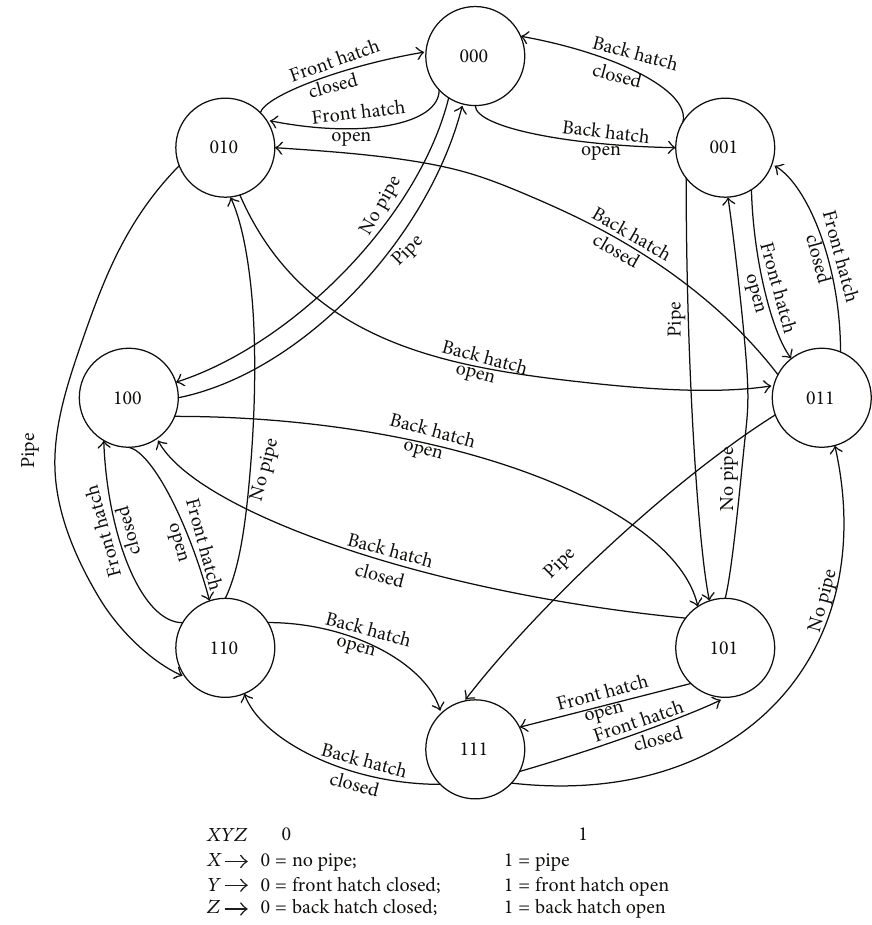
Figure 2: Discrete automaton for state switching in the first zone of the industrial furnace